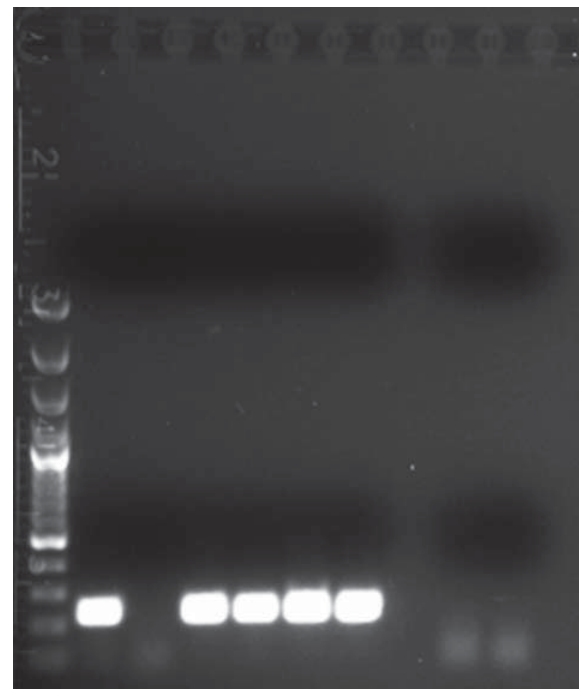
Figure 2- Detection of Helicobacter pylori with nested Polymerase Chain Reaction (PCR) of the second PCR reaction. Description of results: 1- Gene Ruler